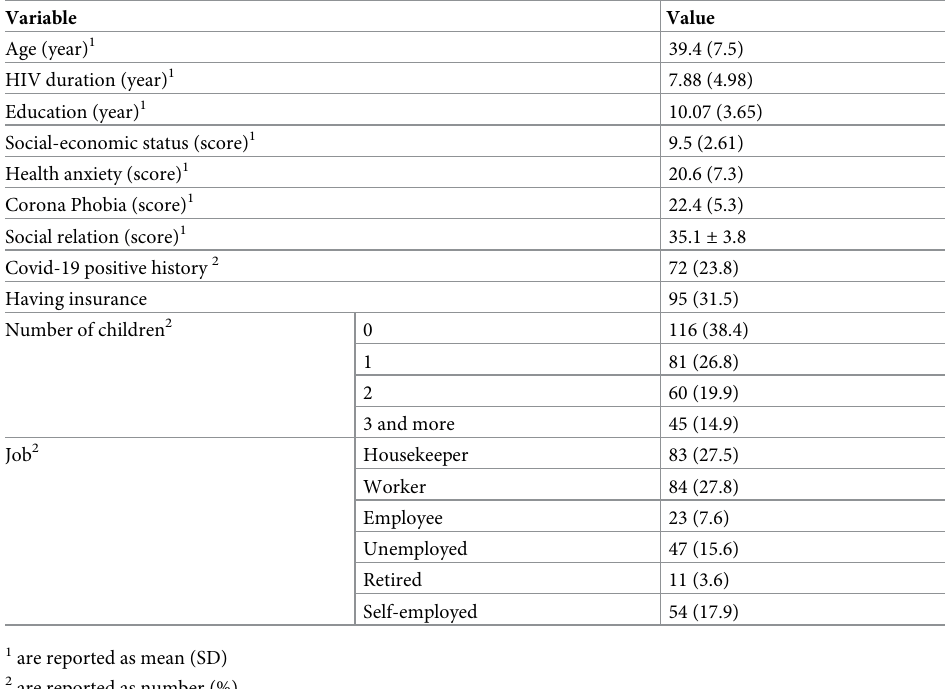
Table 1. Sociodemographic characteristics of participants.